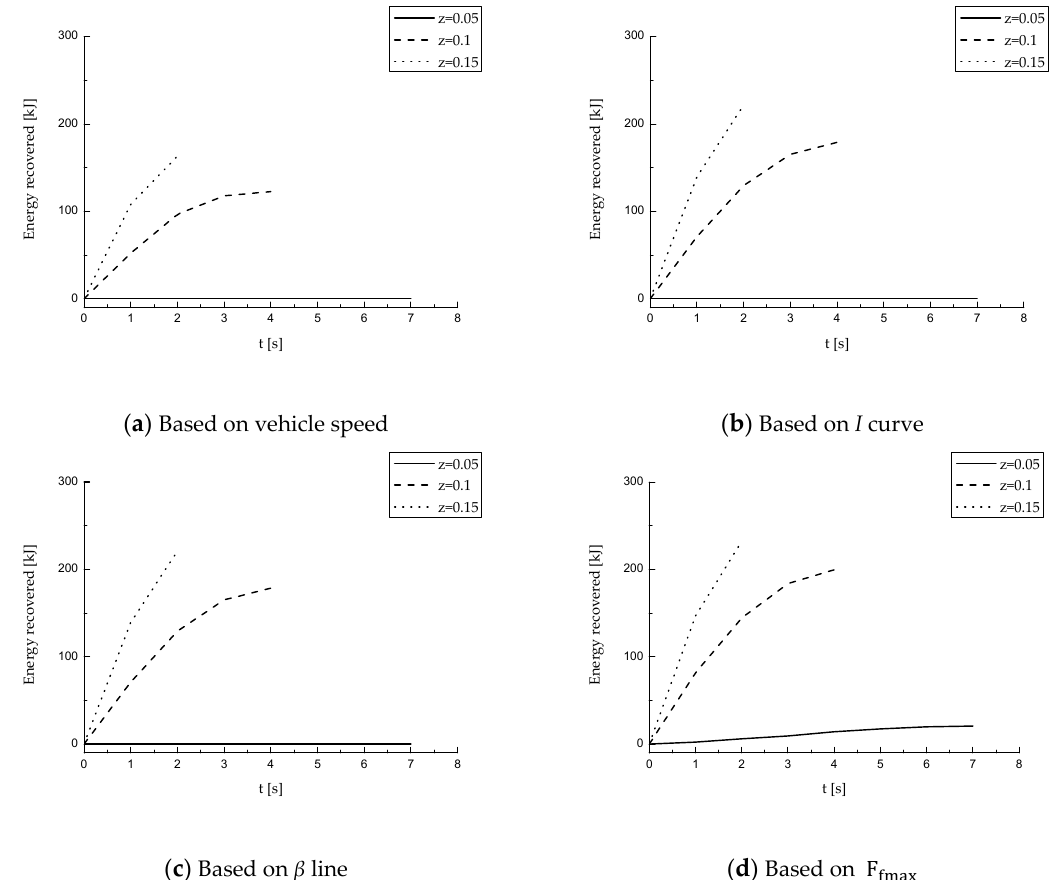
Figure 9. Different strategies recover energy at full load. ( a ) Based on vehicle speed; ( b ) based on I curve; ( c ) based on β line; ( d ) based on F fmax .